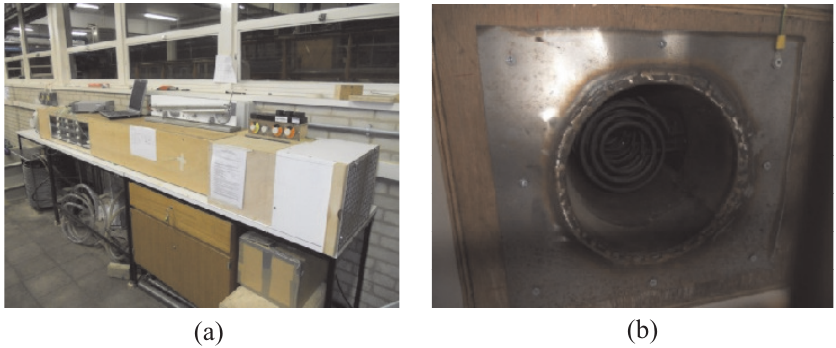
Figure 1. ( a ) The complete phase change material (PCM) system and ( b ) the heating element.